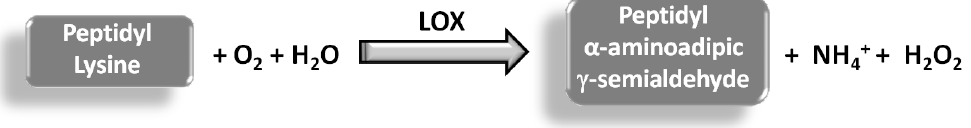
Figure 1. The reaction catalyzed by LOX. LOX activity allows the oxidation of peptidyl lysine residues in collagen and elastin chains to the corresponding peptidyl aldehydes.